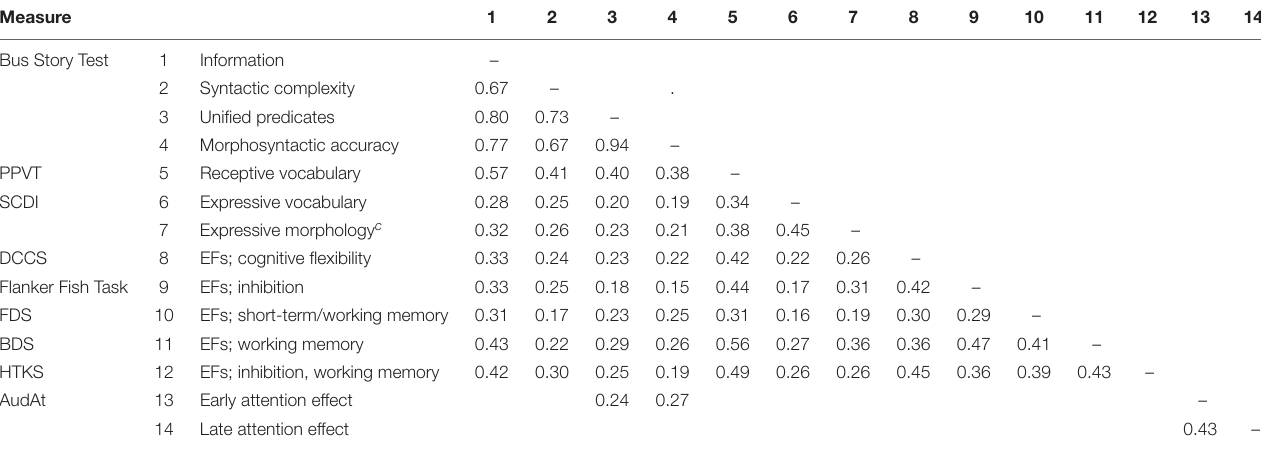
TABLE 2 | Significant Spearman correlations for language, EF, and selective attention measures. Measure